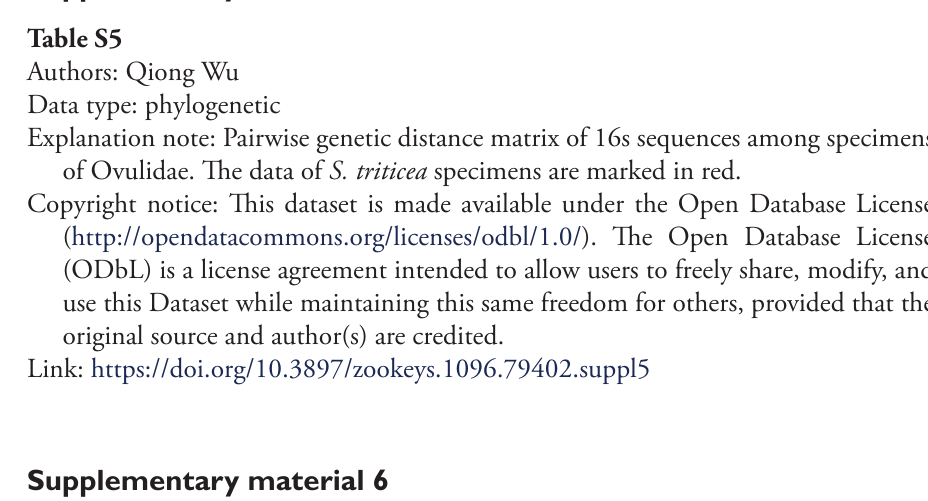
Data type: phylogenetic